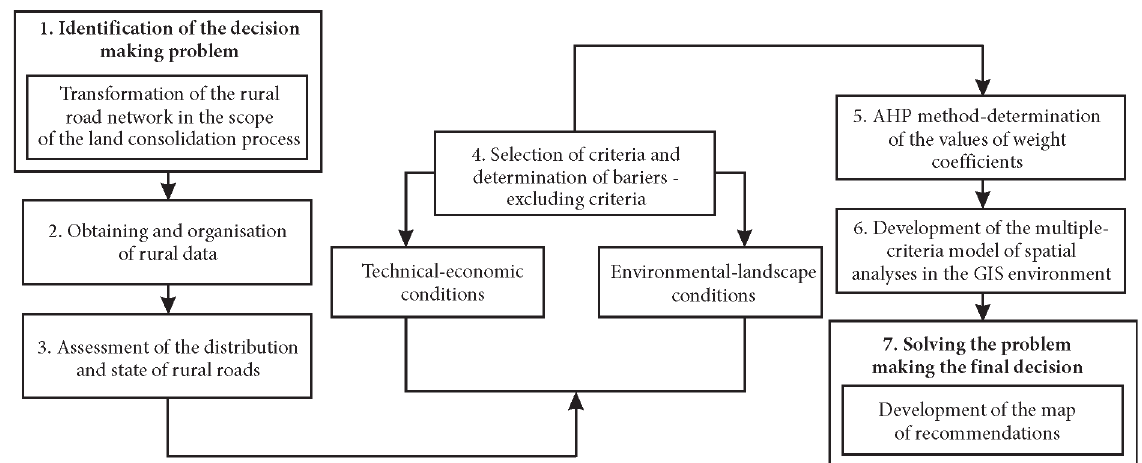
Fig. 2. Diagram of the proposed methodology of development of the network of rural roads in the process of land consolidation with the application of the multiple-criteria model of spatial